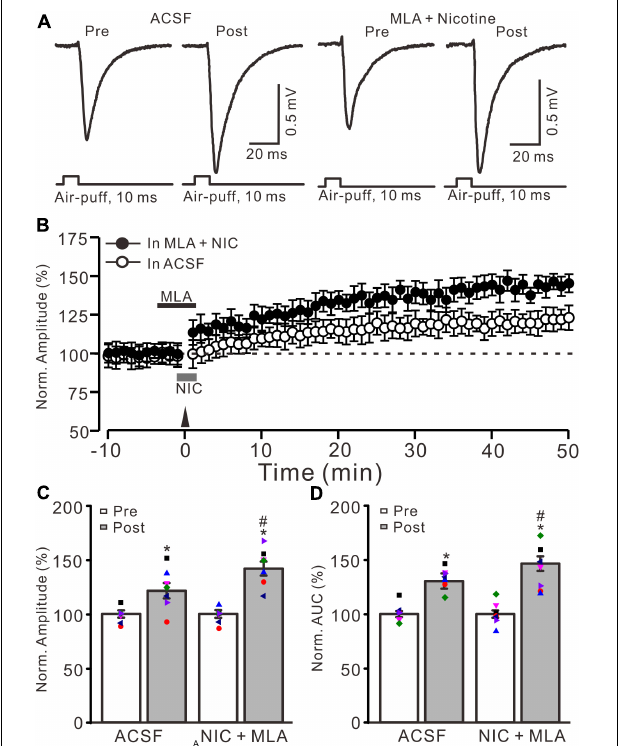
FIGURE 2 | α 7 nicotinic acetylcholine receptors antagonist failed to prevent the nicotine-induced enhancement of MF-GrC LTP. (A) Representative extracellular recording traces illustrating facial stimulation (10 ms, 60 psi)-evoked responses before and after delivery of 20 Hz (240 pulses) stimulation in the absence (ACSF) and the presence a mixture of α 7 nAChR antagonist, MLA (1 µ M), and nicotine (NIC; 1 µ M). (B) Summary of data showing the time course of normalized amplitude of the response before and after delivery of 20 Hz facial stimulation (arrow head) in the absence (ACSF; open circle) and presence (filled circle) a mixture of MLA (1 µ M) and nicotine (NIC; gray bar). (C) Bar graph showing normalized amplitude before (pre) and after (post) delivery of 20 Hz stimulation in treatment of ACSF and a mixture of MLA and nicotine (NIC). (D) Pooled data showing normalized AUC of